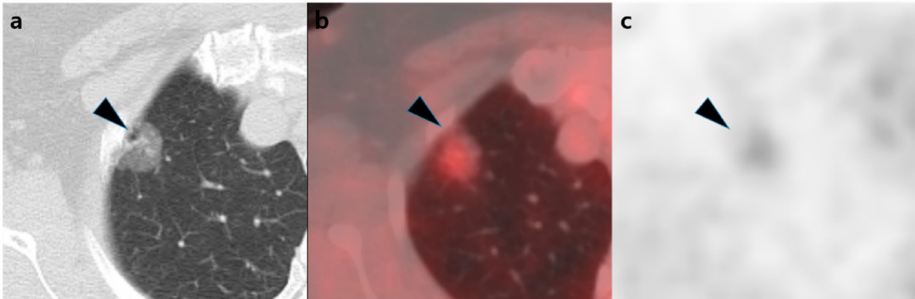
Figure 2. An example of an adenocarcinoma. A 58-year-old woman’s chest computed tomography showing a 20 mm ground-glass nodule (black arrow head) ( a ) with visually positive [ 18 F]FDG uptake ( b , c ). The Hounsfield units value of the nodule was − 436, and the SUV max increased from 1.99 to 3.70 after tissue fraction correction, which was higher than the cutoff value of 2.50. The nodule was diagnosed as adenocarcinoma after